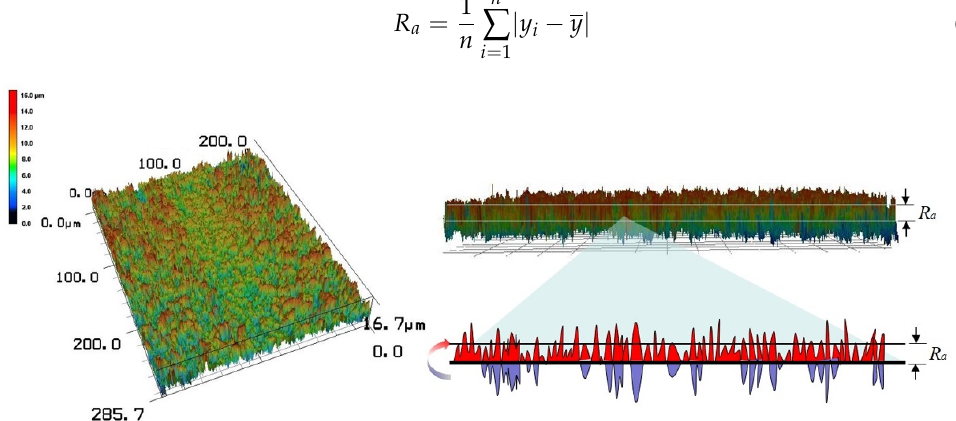
Figure 4. An example of three-dimensional surface profile and the corresponding R a for one sampling area on a substrate with D4-100n scheme. Table 2. The p c and average 𝑅 (cid:3028) values of the samples treated with different parameter schemes. Schemes Label D2-100n *